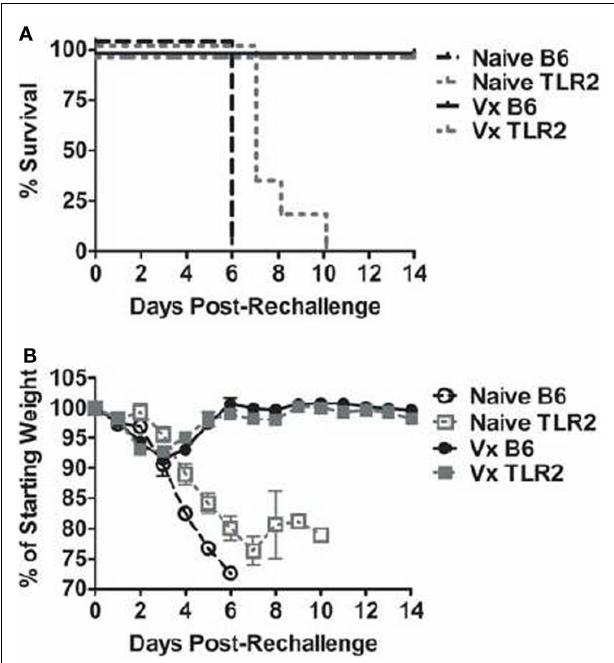
FIGURE 2 |TLR2 KO previously inoculated with LVS clpB survive a lethal LVS challenge. B6 orTLR2 KO mice were intranasally inoculated with 5 × 10 4 CFU LVS clpB or were left naive.Thirty-five days later, mice were intranasally challenged with 5 × 10 3 CFU LVS and (A) survival was determined. (B) Mice were weighed daily and weight loss is reported as a percentage of starting weight. Data are combined from two independent experiments. n = 6–10